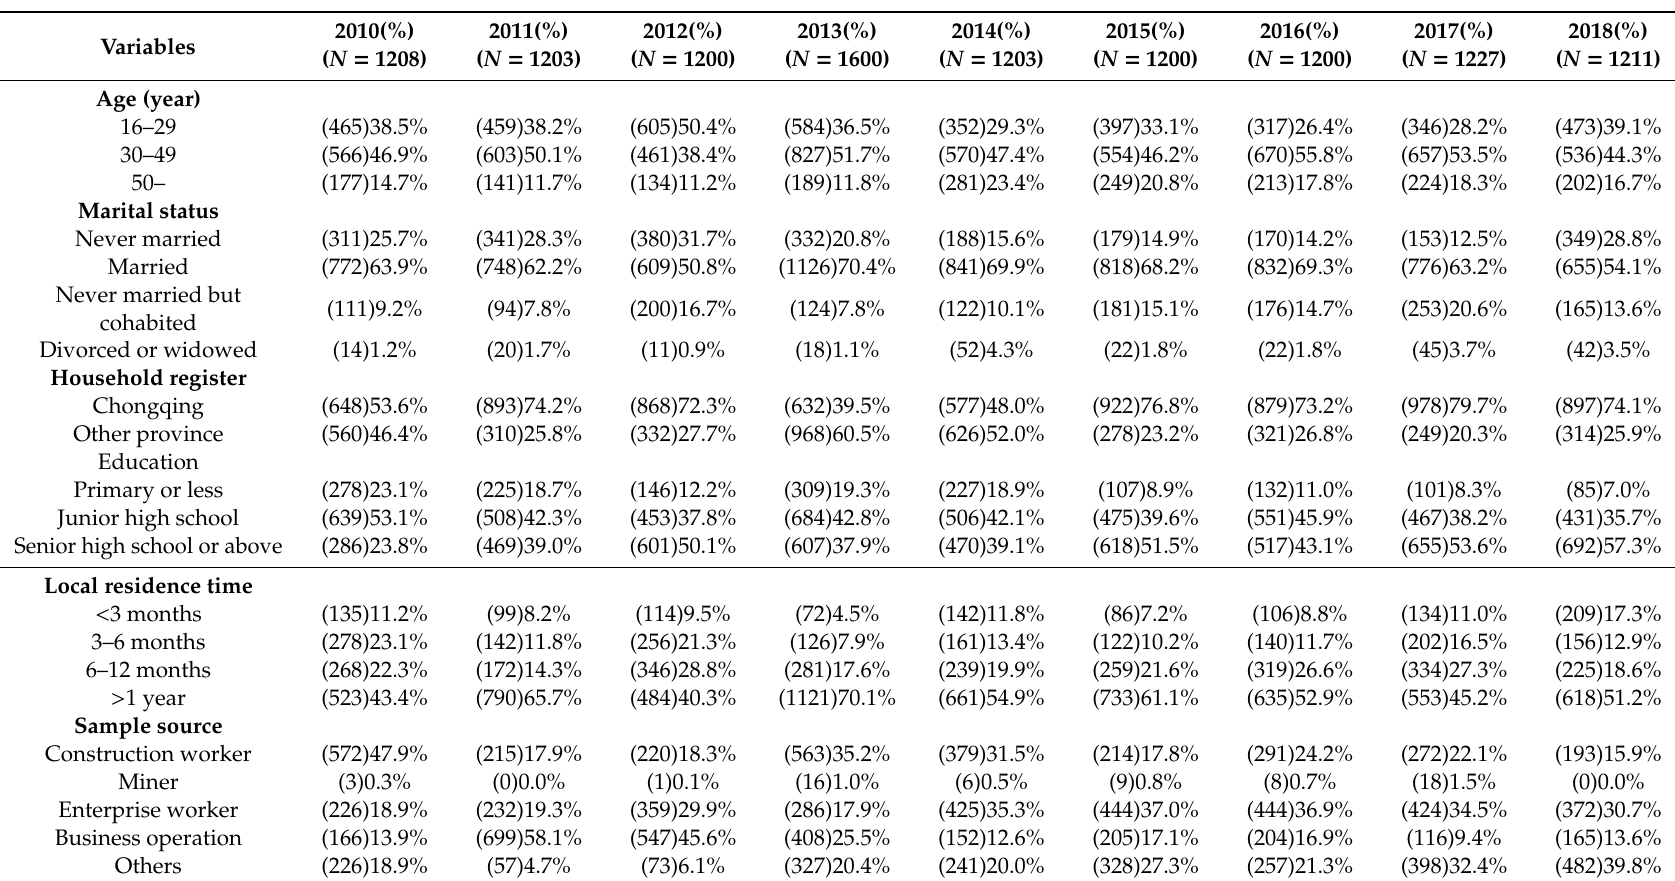
Table 1. Socio-demographic characteristics of male migrant workers (MMWs) between 2010 and 2018 in Chongqing ( N =